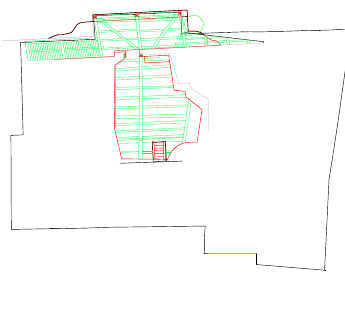
Figure 5. Basement Structural RCP